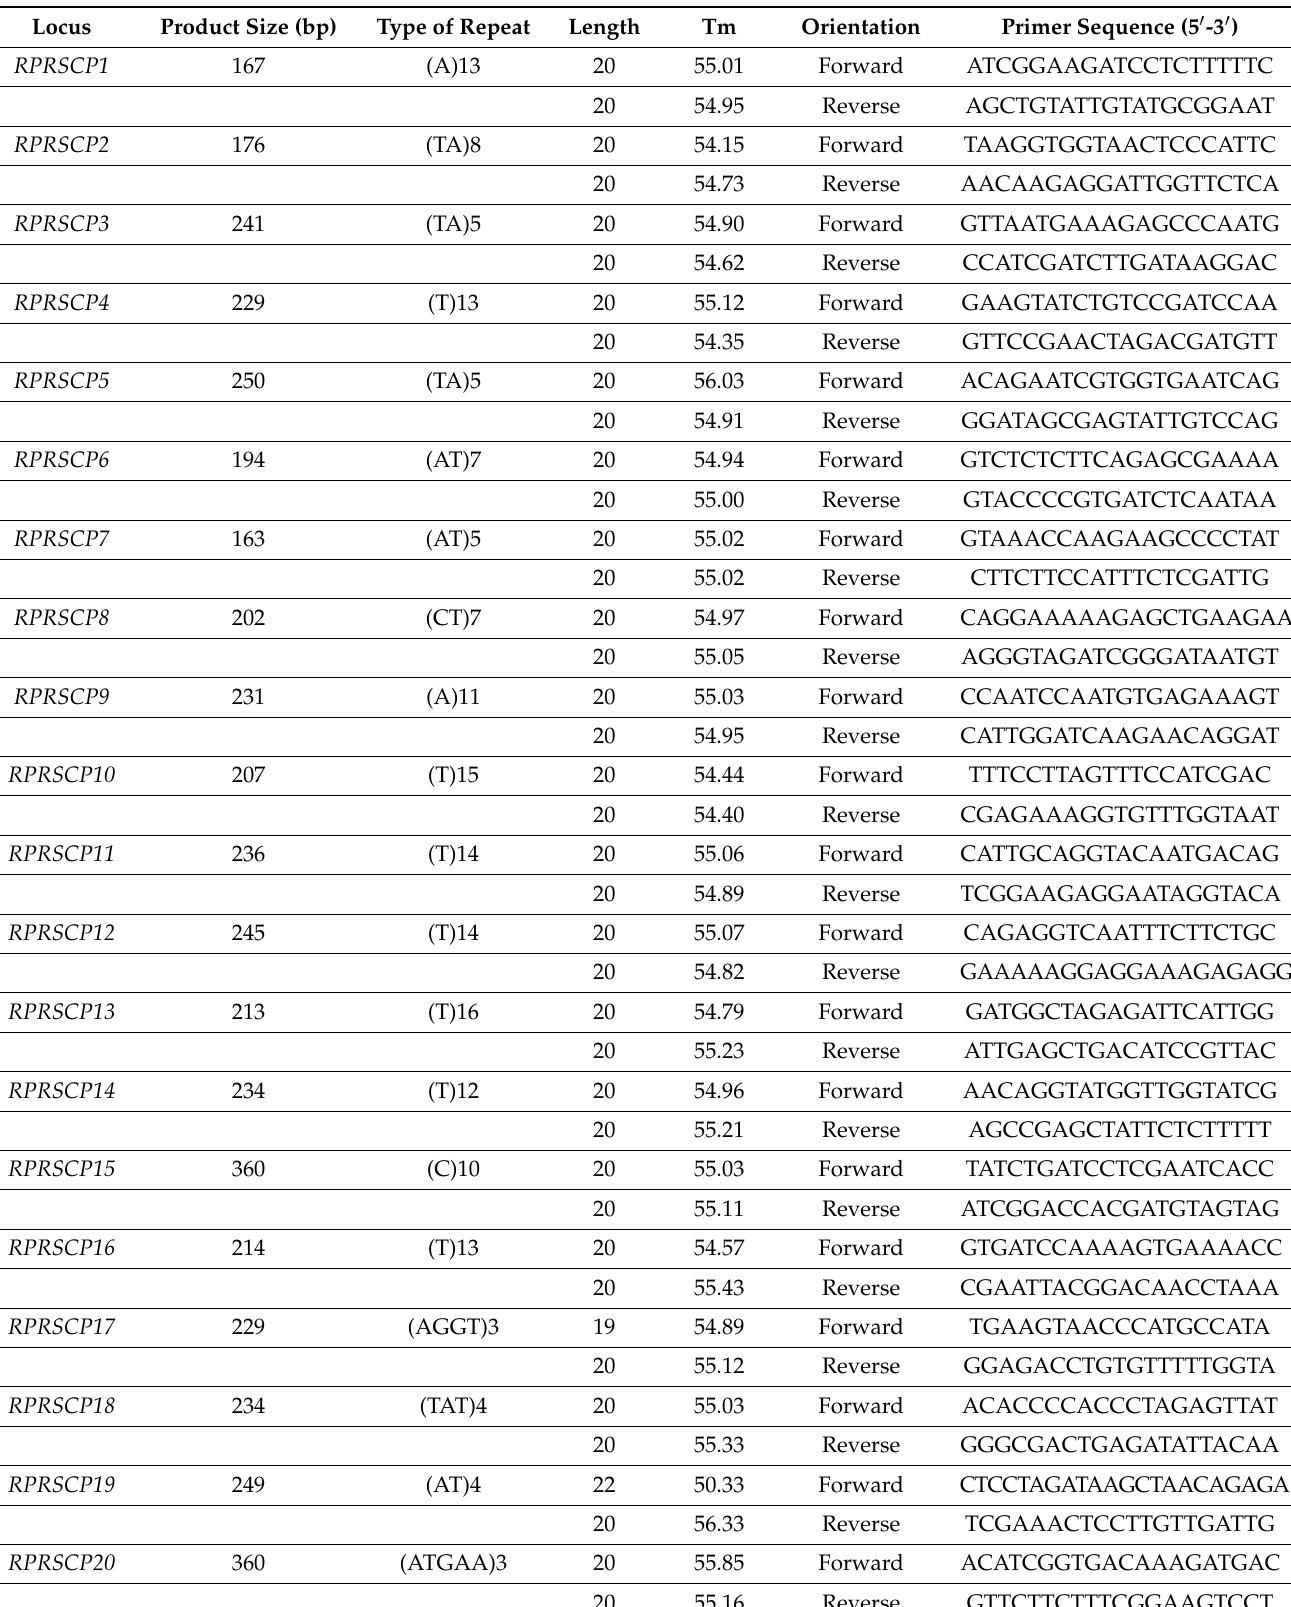
Table 4. Microsatellite loci, primer sequences designed from the flanking region of the SSR sequences identified, and annealing temperatures